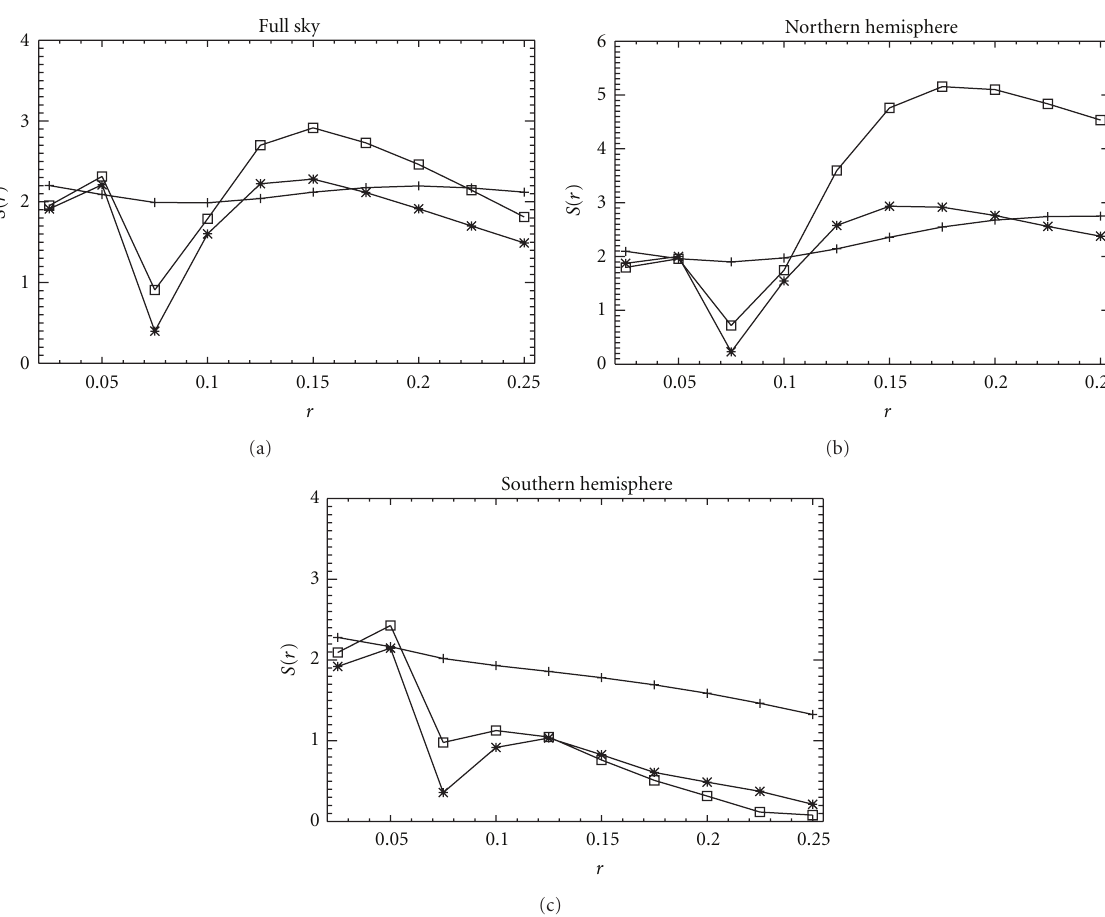
Figure 6: Deviations of the (combined) moments of the α distribution of the WMAP 3-year data with the Kp0-mask as a function of the scaling range r . The “+” symbol denotes the mean, the “ ∗ ” symbol denotes the standard deviation, and the boxes denote the χ 2 combination of the mean and standard